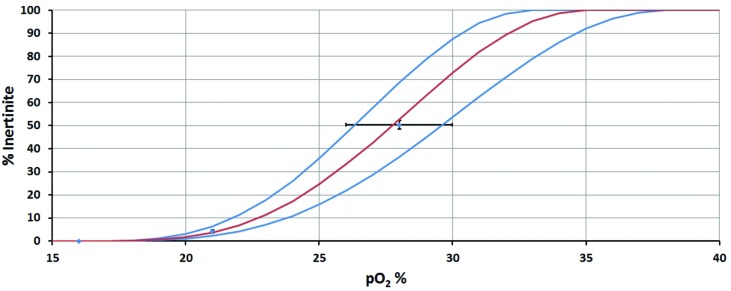
Inertinite to p(O2) calibration curve. Points, and associated error bars, show the data constraints. S-shaped curves are assumed, to ensure smooth transition from 0% inertinite to 100% inertinite.